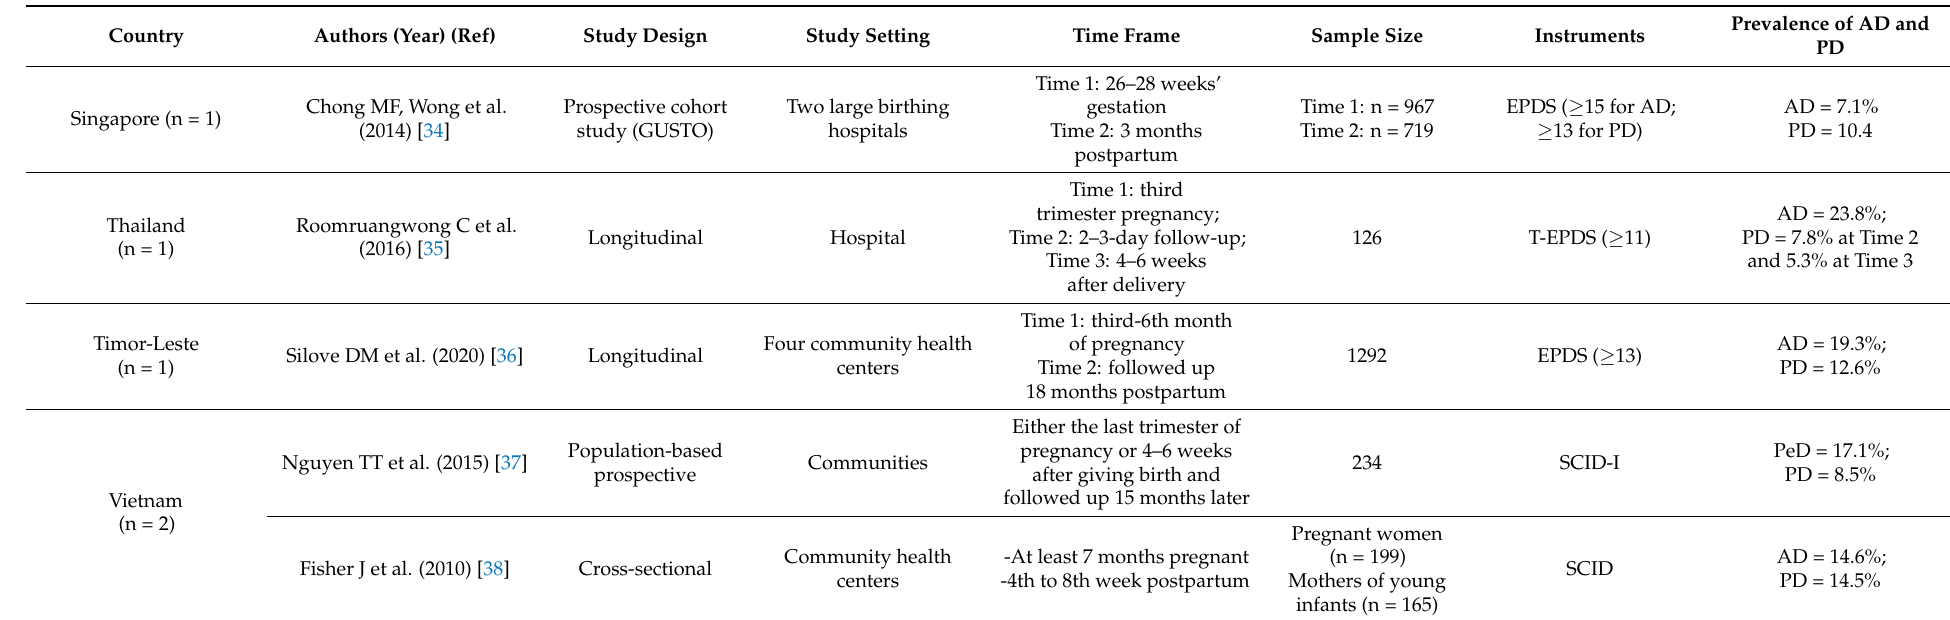
Table 4. Prevalence of perinatal (both antenatal and postnatal)